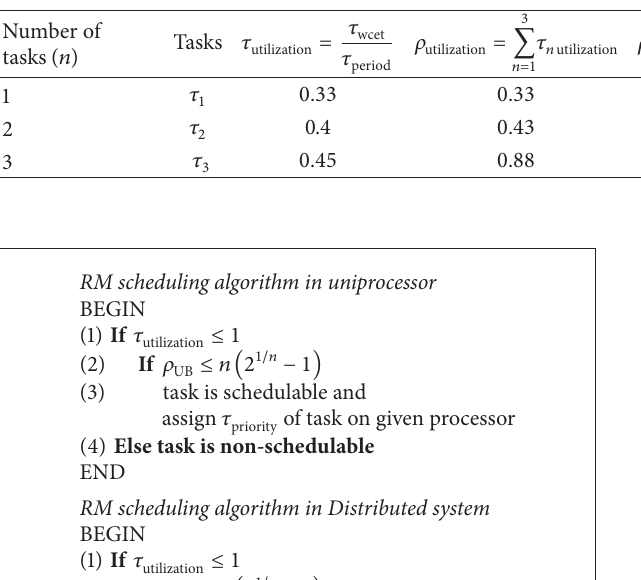
on different number of tasks 𝑛 UB